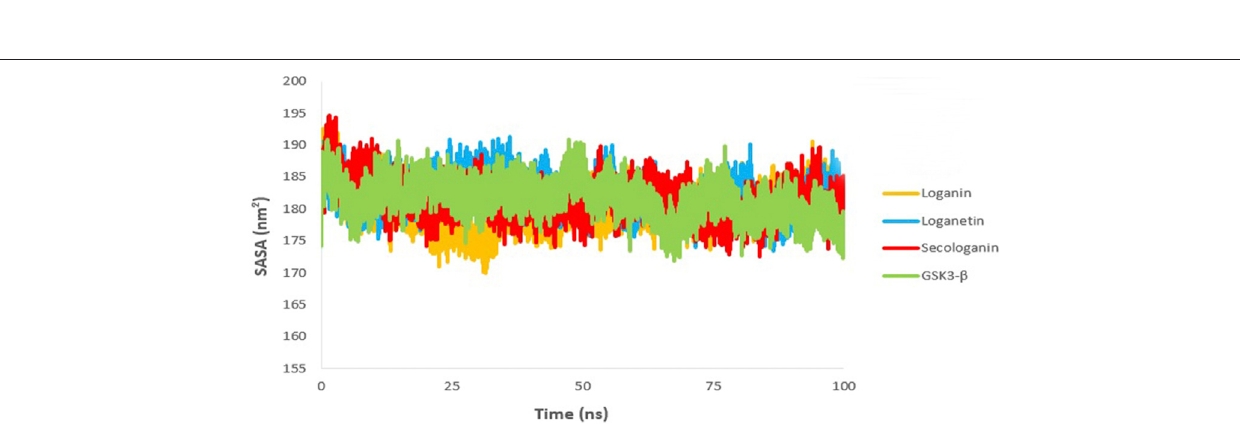
Figure 12 . The average number of hydrogen bonds for loganin_GSK3- β ( Figure 12A ) and loganetin_GSK3- β was ( Figure 12B ) 3 and 2, respectively. But the hydrogen bonds of secologanin_GSK3- β are variable.